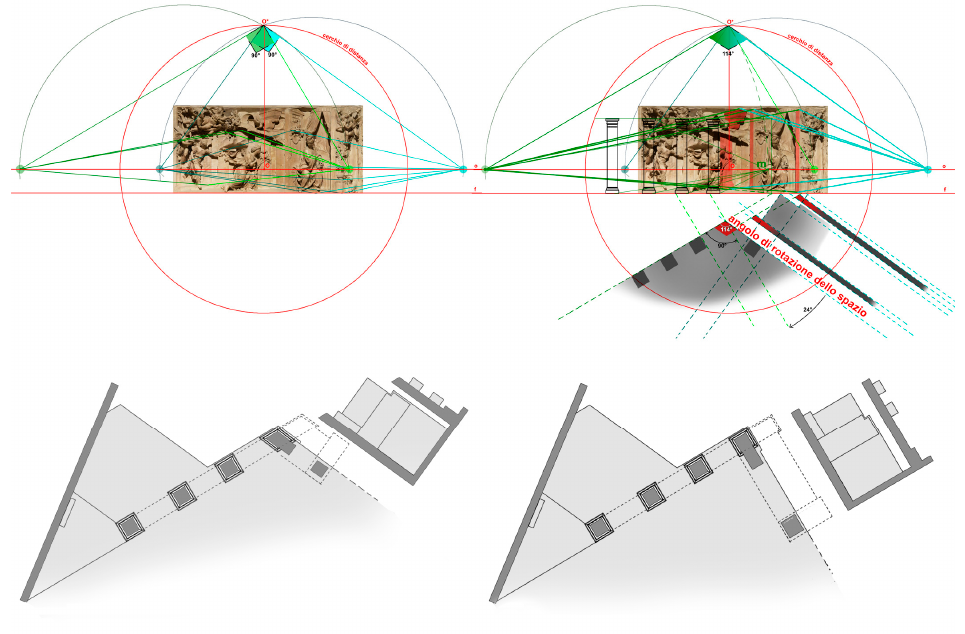
Figure 5. Perspective restitution of the space. Upper left: identification of the perspective elements; upper right: identification of the elements formally altered with respect to the supposed right angles; below: comparison between the plan with deformations and the rotation of the spaces and the reconstruction according to the proposed